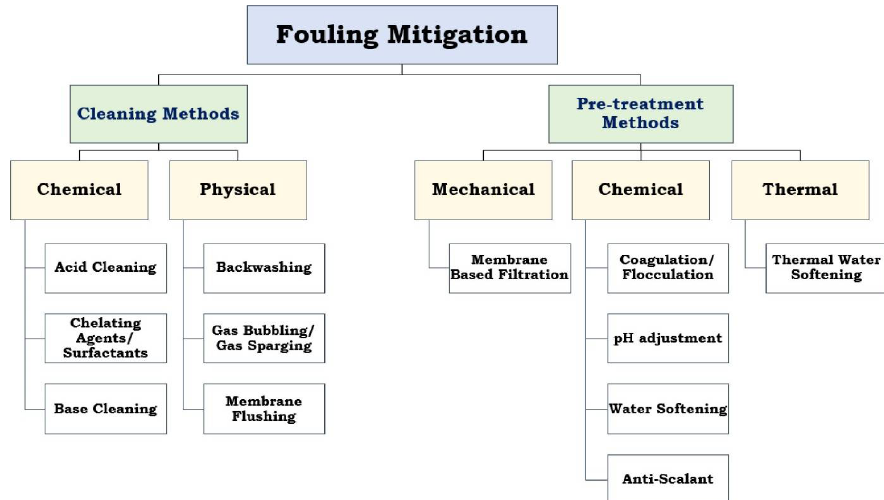
Figure 25. Different fouling mitigation methods [132].